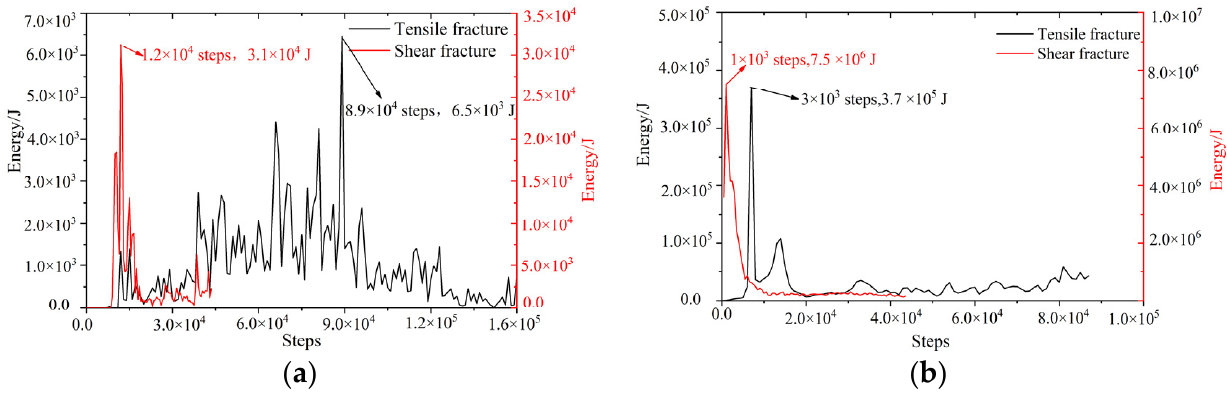
Figure 8. Kinetic energy change curves of source and roadway under different fault forms: ( a ) Source kinetic energy; ( b ) Roadway kinetic energy.